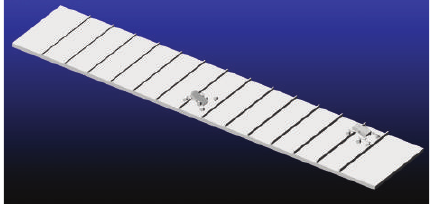
Figure 10: Final state of simulation in scenario 2.